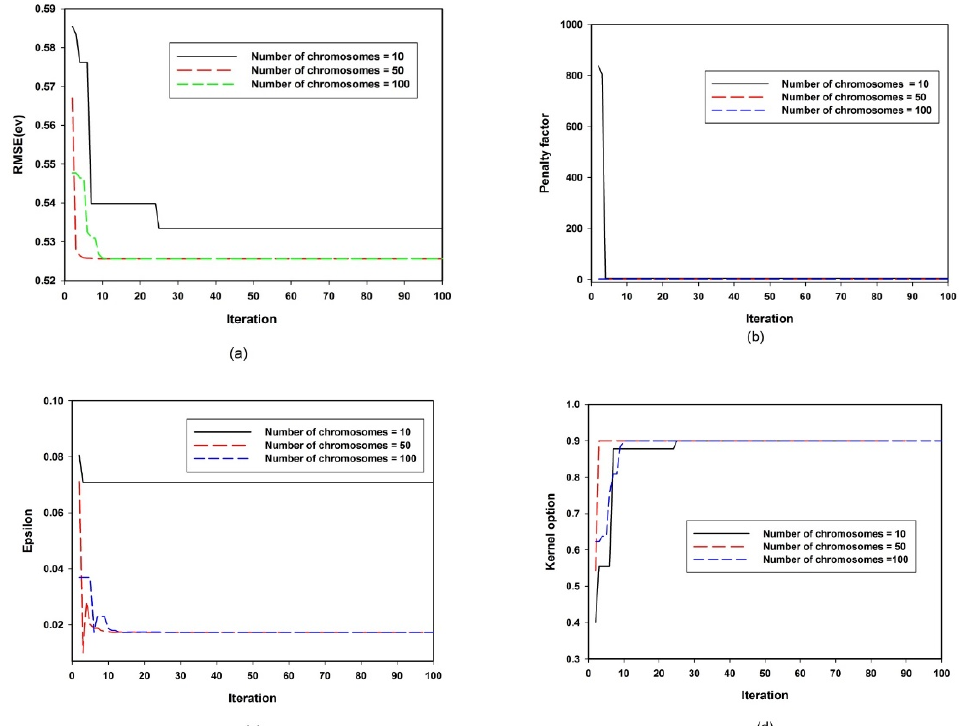
Figure 2. Dependence of chromosome population size on hybrid SVR-GA model convergence ( a ) effect of chromosome size on error convergence, ( b ) effect of chromosome size on the penalty factor, ( c ) effect of chromosome size on epsilon error threshold, ( d ) effect of chromosome size on Gaussian kernel parameter.